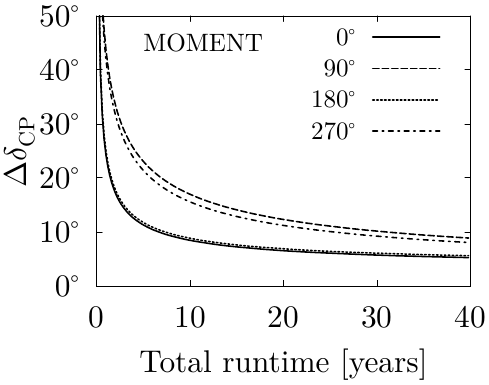
Figure 3. The e(cid:11)ect of statistics on the precision measurement of (cid:14) CP . The 1 (cid:27) con(cid:12)dence level uncertainties for (cid:14) CP are shown as a function of the total running time of the experiment. The (cid:1) (cid:14) CP distributions are shown for the true values (cid:14) CP = 0, 90 (cid:14) , 180 (cid:14) and 270 (cid:14) . The results are independent of the mass